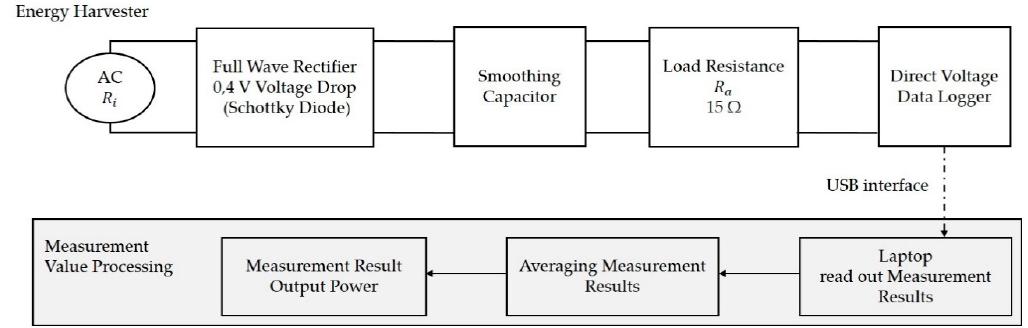
Figure 4. Measuring principle and measurement value processing.